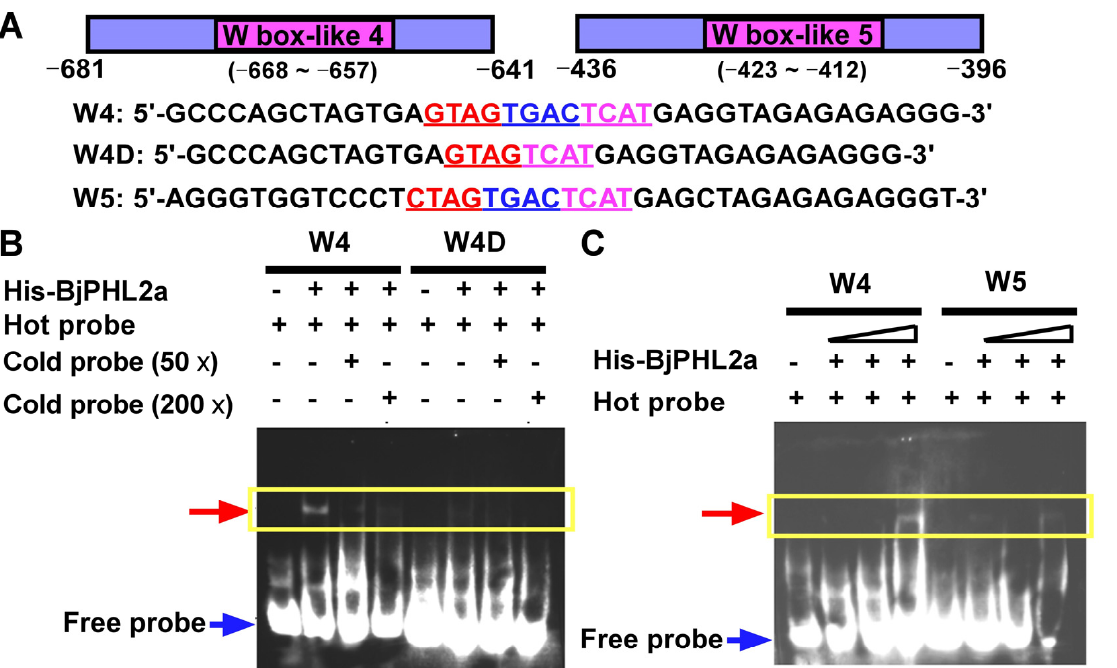
Figure 9. BjPHL2a binds to the Wbl-4 element in EMSA. ( A ) Diagrams of probes W4, W4D (W4 mutant), W5, and their nucleotide sequences. W4 contains Wbl-4 element. W4D is a W4 mutant lacking four core base of Wbl-4 element. W5 contains Wbl-5 element. Numbers indicate the nucleotide positions in BjCHI1 promoter. ( B , C ) Electrophoretic mobility shift assays (EMSA) were performed with biotin-labeled (hot probe) or unlabeled probes (cold probe) and recombinant His-BjPHL2a proteins. Specific combinations are shown indicated by a yellow box. An equal amount of BjPHL2a protein or hot probe was used in all lanes. Cold probes were added in 50-fold (50 × ) or 200-fold (200 × ) excess as binding competitors. The bound and free hot probes are indicated by arrows on the left.